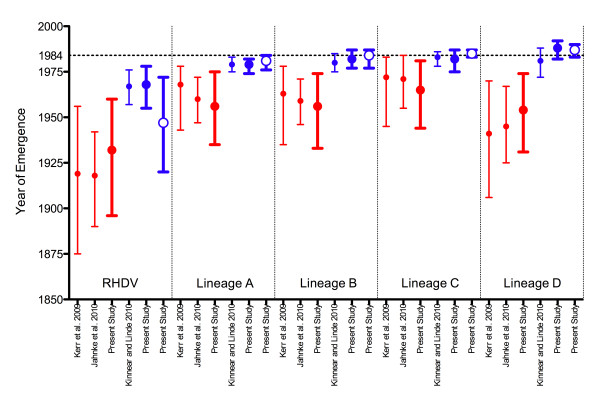
Estimated years of emergence for RHDV lineages. Mean years are shown with 95% HPD intervals for the entire virulent RHDV clade and each of its four lineages. Closed circles denote estimates based on the VP60 gene, while open circles denote estimates based on the RdRp gene. Years of emergence estimated in the present study are bolded, while those derived from the literature are not. Estimates based on datasets that included AY269825 are shown in red, while those based on datasets that excluded AY269825 are shown in blue. The source of the MCC tree from which each estimate was inferred is indicated on the x-axis.